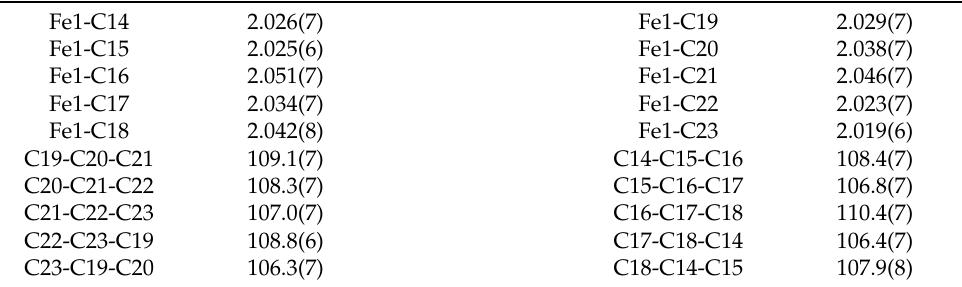
Table 1. Selected bond lengths (Å) and angles ( ◦ ) in L